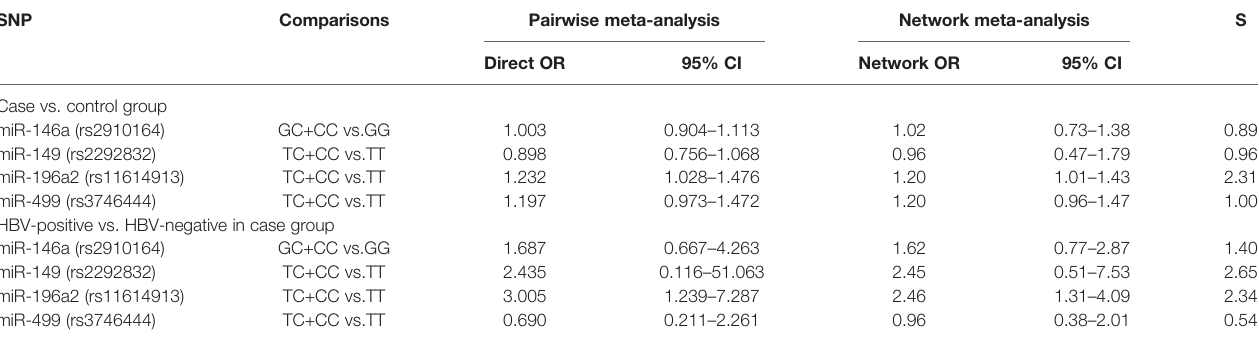
TABLE 4 | The comparisons of pairwise and network